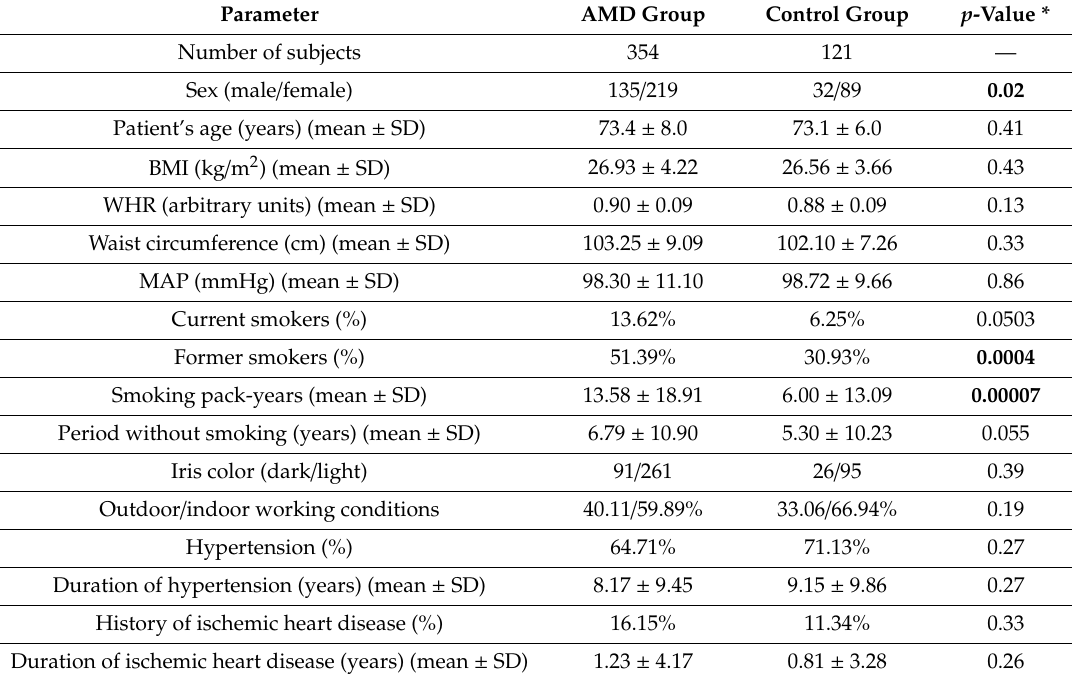
Table 1. Characteristics of the study